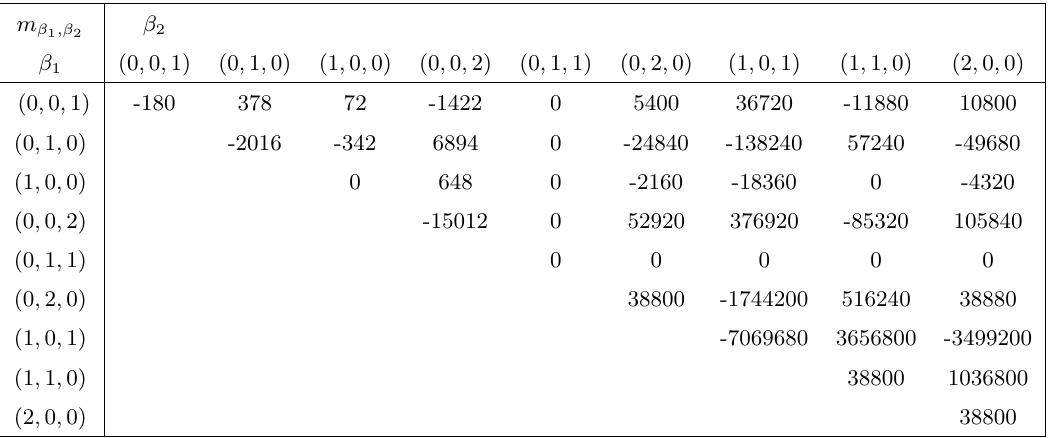
Table 8 . Meeting invariants for M E 8 P 1 × P 2